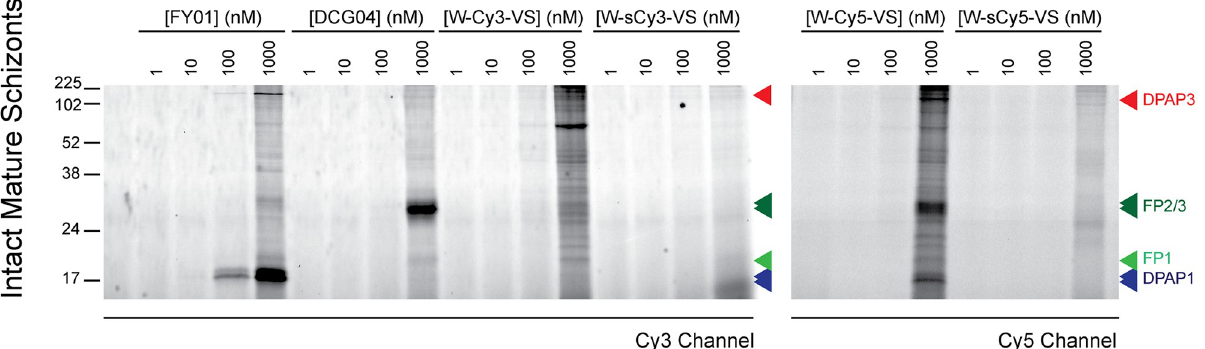
Fig 3. Labelling of cysteine protease in live parasites. Very mature schizonts were diluted ten-fold in RPMI and treated with different concentrations of probes for 1 h. Samples were run on a SDS-PAGE gel, and the labelled proteins detected using at fluorescence scanner. Bands corresponding to DPAP1, DPAP3, FP1, and FP2/3 are indicated by blue, red, light green, and dark green arrowheads, respectively. Two additional biological replicates of this experiment are shown in S4 Fig.